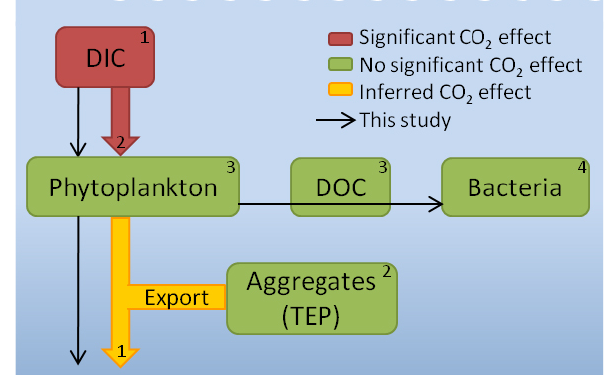
Fig. 1. Carbon fluxes between the major food-web compartments of this study and the previous published CO 2 effect on these compart- ments and fluxes in the PeECE III 2005 mesocosm study. 1 Riebesell et al. (2007) found increased cumulative DIC drawdown at in- creased p CO 2 during the bloom and inferred enhanced export at high p CO 2 ; 2 Egge et al. (2008) demonstrated increased cumulative 14 C incorporation at higher p CO 3 Schulz 2 in the post-bloom phase; et al. (2008); 4 Allgaier et al.